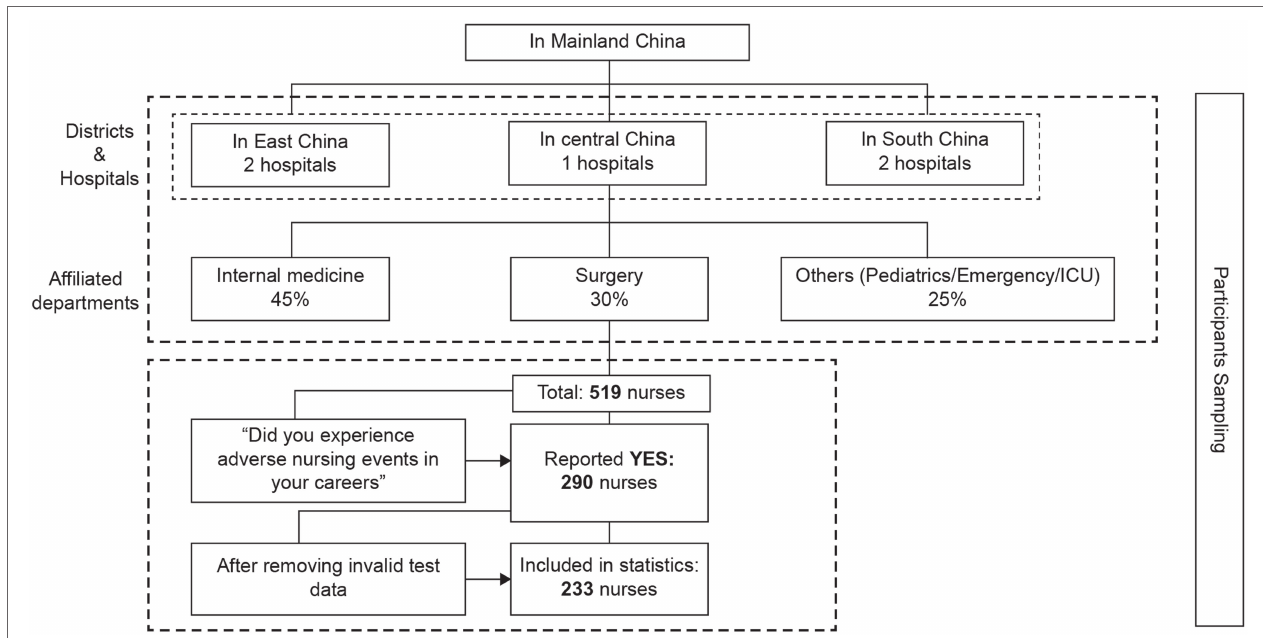
FIGURE 2 | Participants sampling